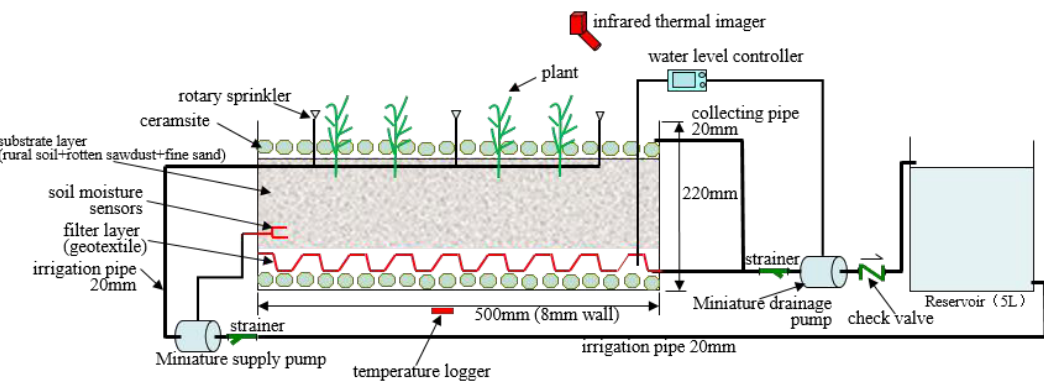
Figure 4. Schematic diagram of the experimental green roof system for integrated rainwater collection and irrigation.